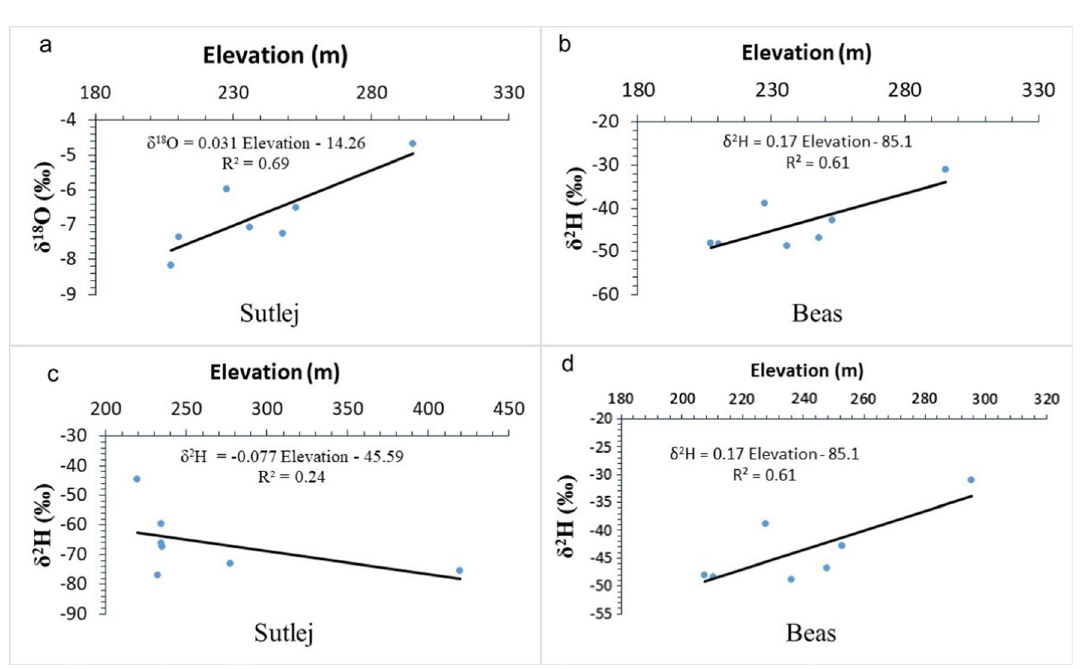
Fig. 13 The linear regression relationships are shown in a δ 18 O and elevation for River Sutlej, b δ 2 H and elevation for River Sutlej, c δ 18 O and elevation for River Beas, and d δ 2 H and elevation for the River